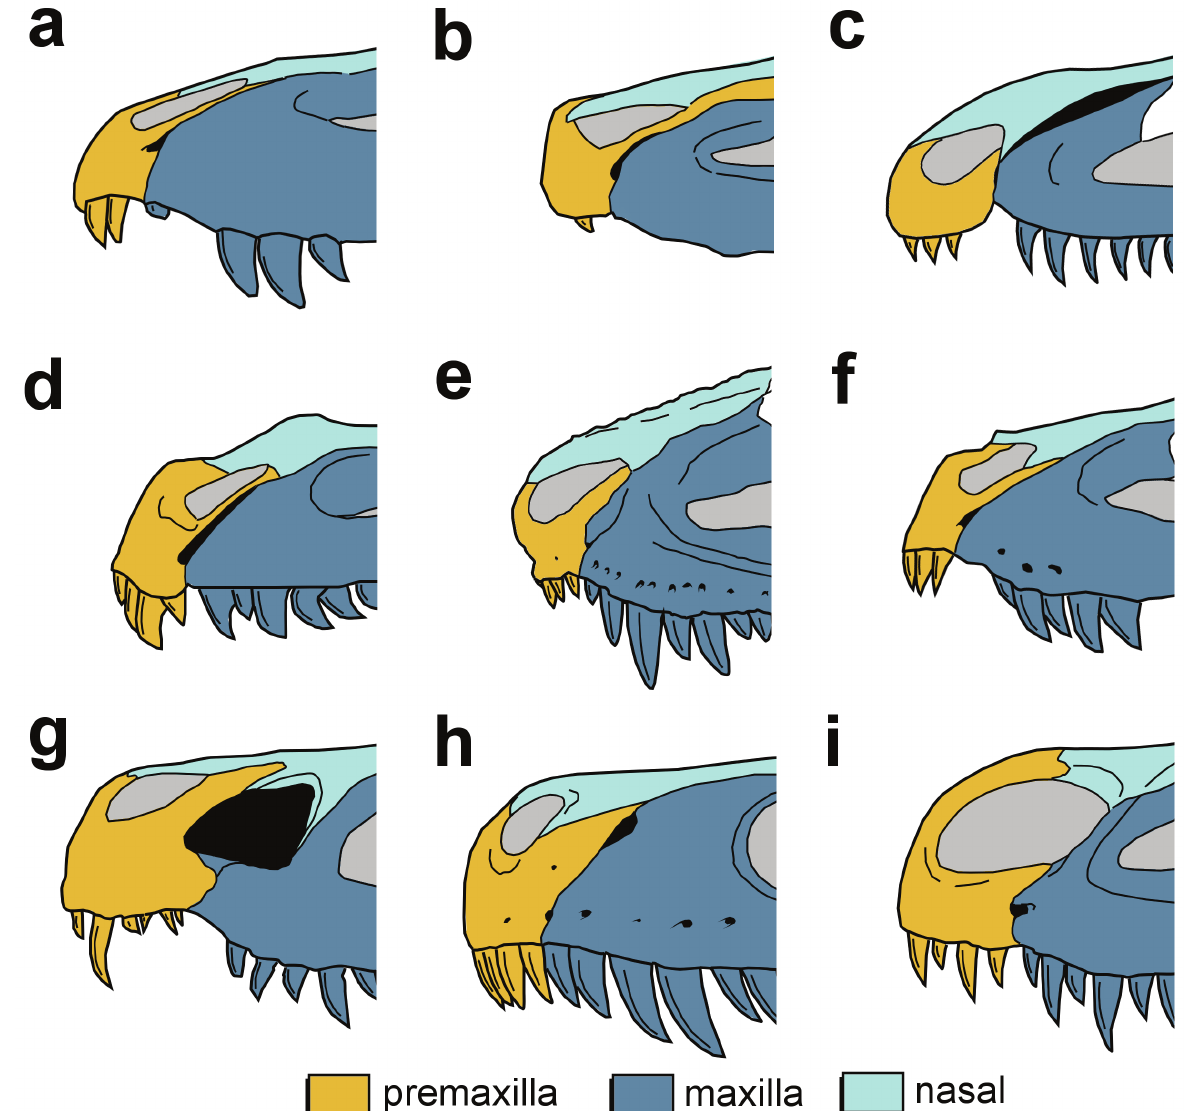
Figure 5 - Schematic drawing depicting the rostral region of selected archosauriforms in left lateral view. The subnarial fenestra is depicted in black. a , Prestosuchus chiniquensis ULBRA-PVT-281; b , Saurosuchus galilei ; c , Luperasuchus fractus ; d , Decuriasuchus quartacolonia ; e , Postosuchus kirkpatricki ; f , Prestosuchus chiniquensis UFRGS-PV-0629-T; g , Shansisuchus shansisuchus ; h , Herrerasaurus ischigualastensis ; i , Batrachotomus kupferzellensis